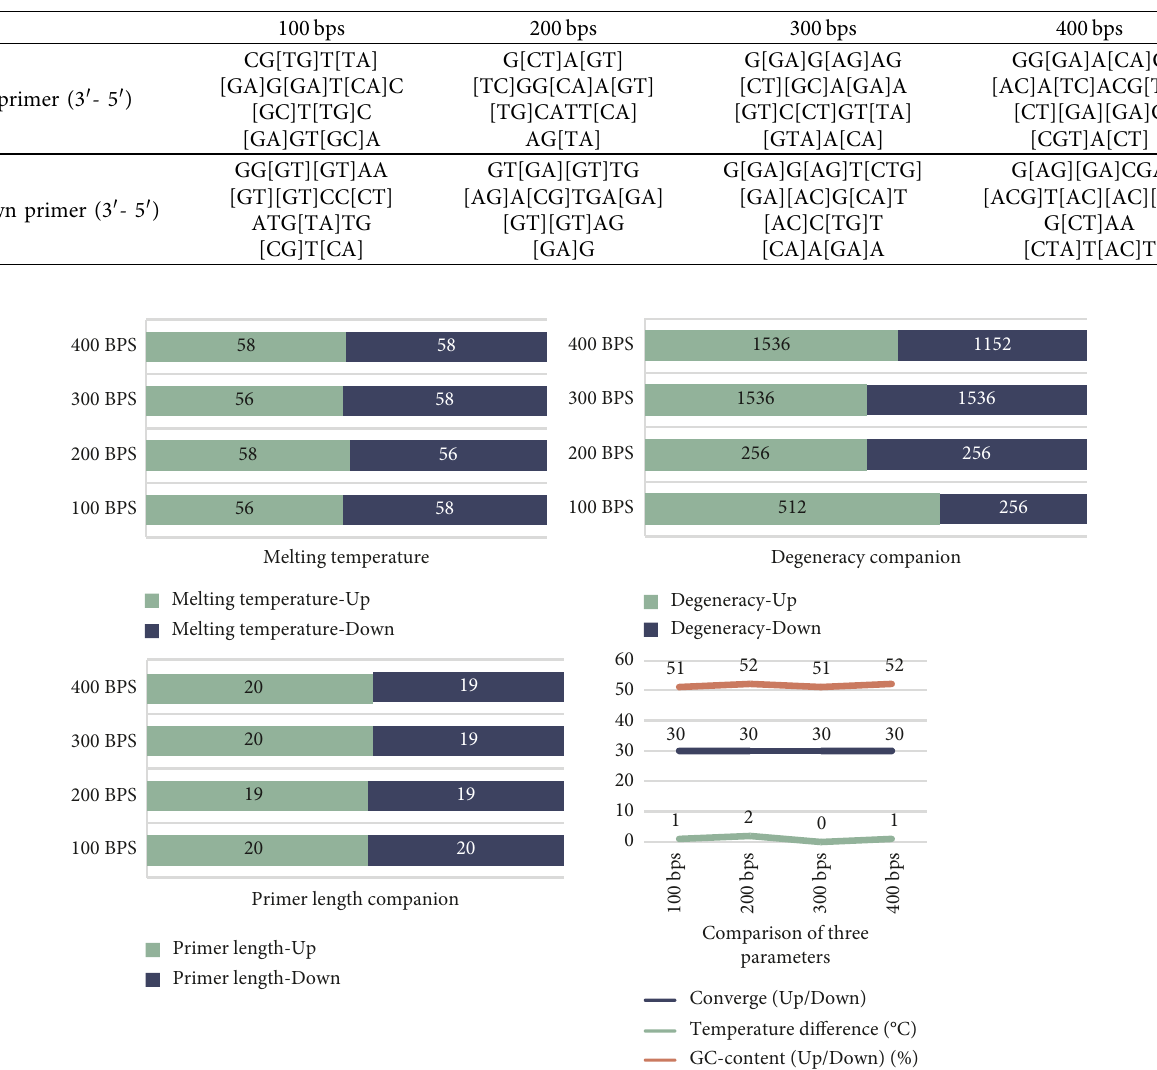
Figure 7: Comparison of four kinds of data at 100bps, 200bps, 300bps, and